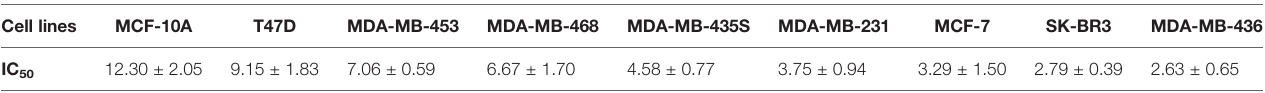
TABLE 1 | IC 50 s of Eth on BC cell